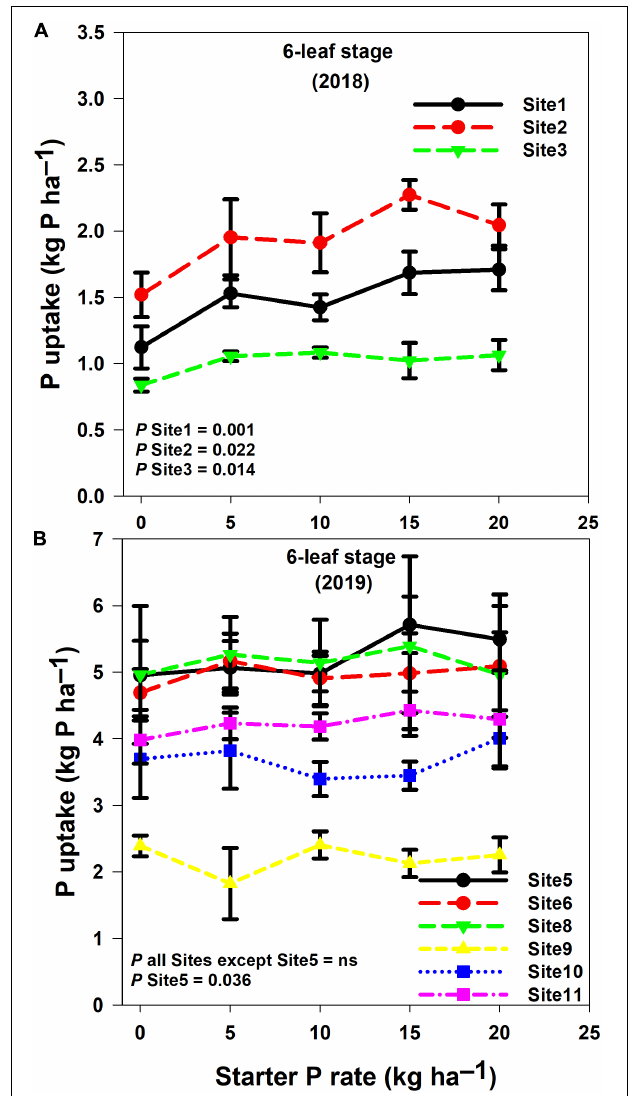
FIGURE 5 | Corn P uptake at 3-leaf stage with application of starter P rates and dairy manure across 11 sites [2018 (A) and 2019 (B) ] in the Fraser Valley, BC. Dairy manure was applied at 6-leaf stage. Error bars represent standard deviations of the means.